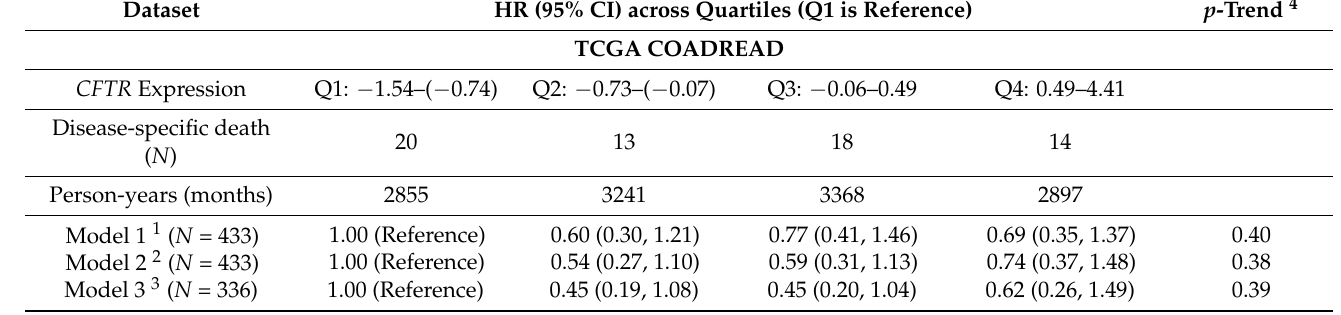
Table 3. Hazard ratio (HR) and 95% confidence interval (CI) for disease-specific death in relation to CFTR mRNA expression, presented as quartiles among individuals with CRC/colon cancer in the TCGA COADREAD and GSE17538 studies.